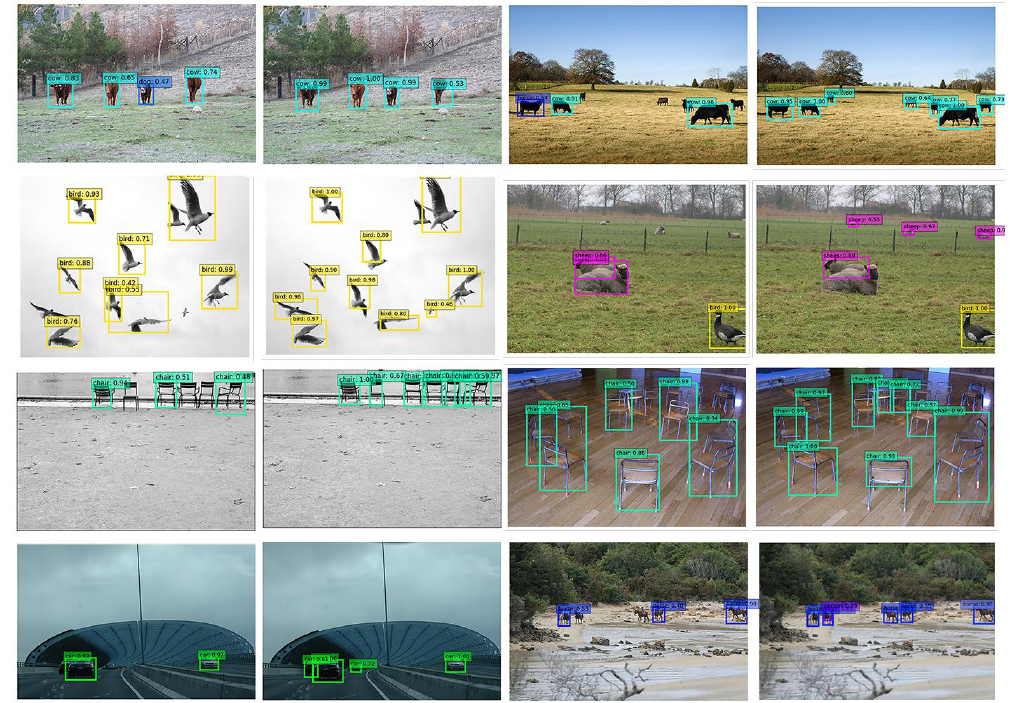
Figure 7. Comparisons of small object detection results between the classical SSD method (the first and third columns) and the Multi-view SSD method (the second and fourth columns).